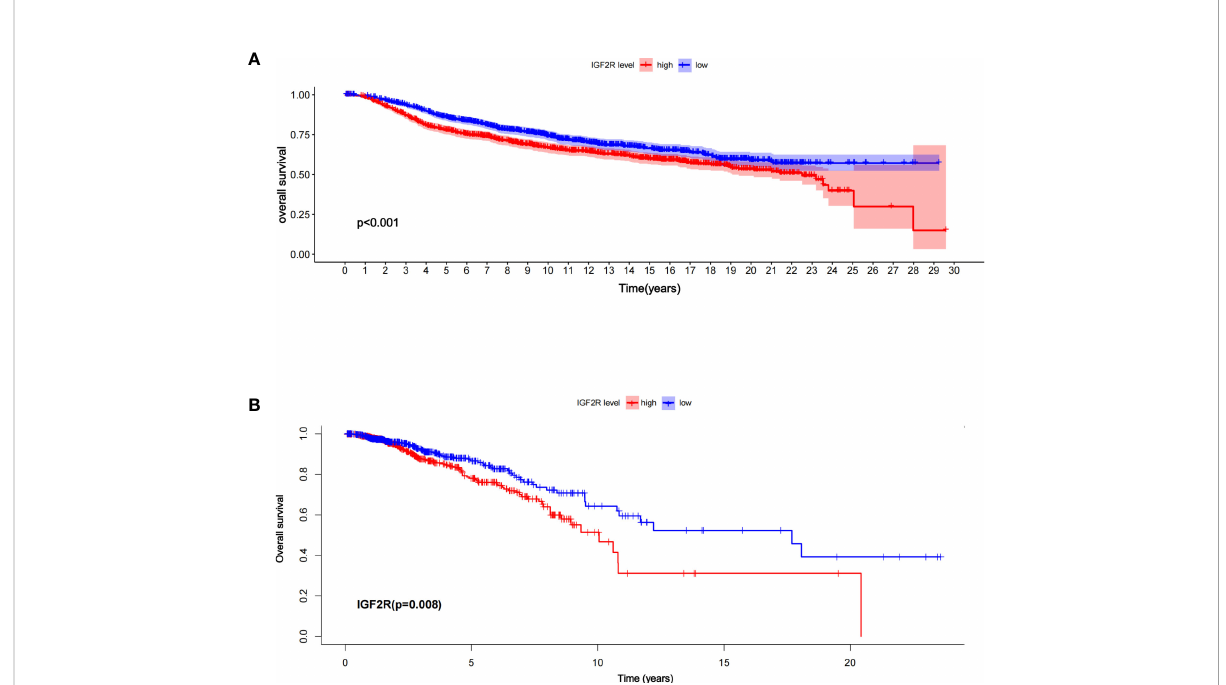
FIGURE 2 Overall survival between the high- and low-risk patients in (A) the TCGA datasets and (B) the METABRIC, according to IGF2R expression.